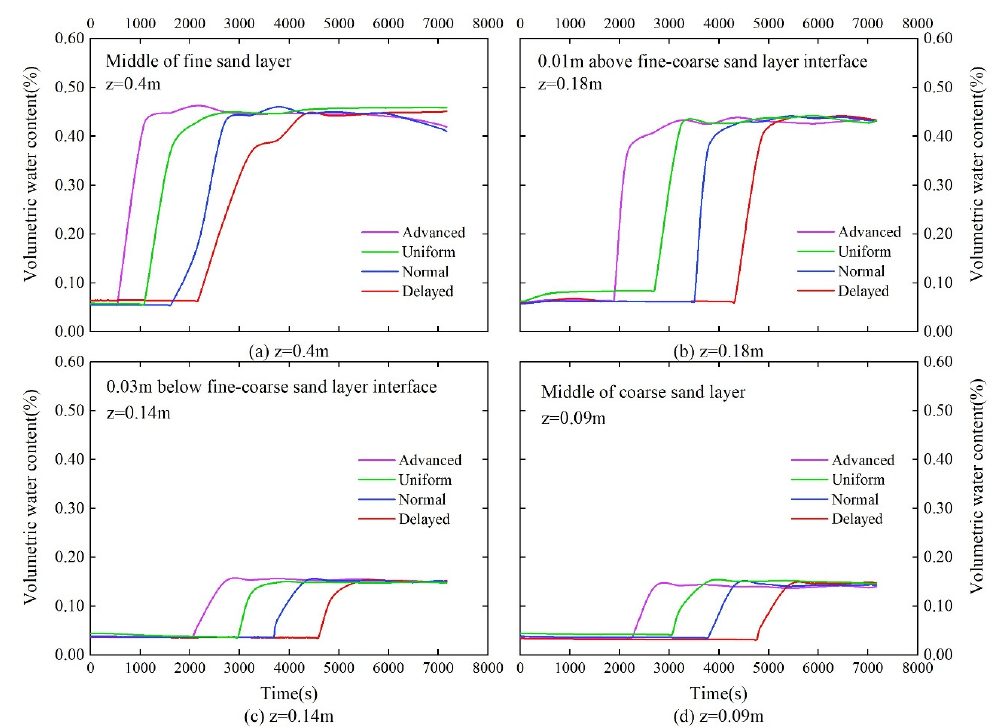
Figure 7. Variations of volumetric water content with time at ( a ) z = 0.4 m, ( b ) z = 0.18 m, ( c ) z = 0.14 m and ( d ) z = 0.09 m under relatively short rainfall duration. Water 2020 , 12 , x FOR PEER REVIEW